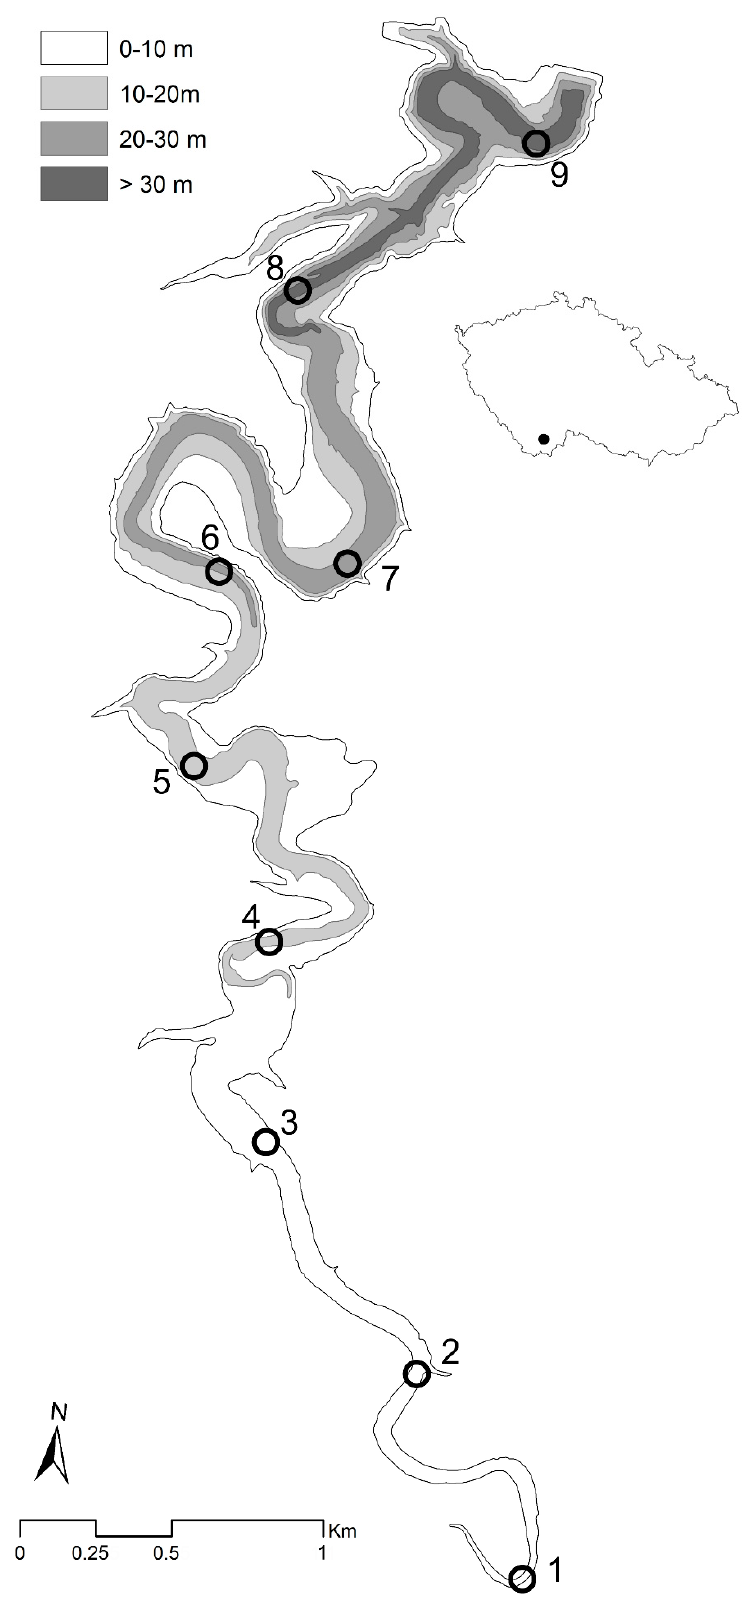
Figure 2. A map of the canyon-shaped Ř ímov Reservoir showing location of the sampling stations.